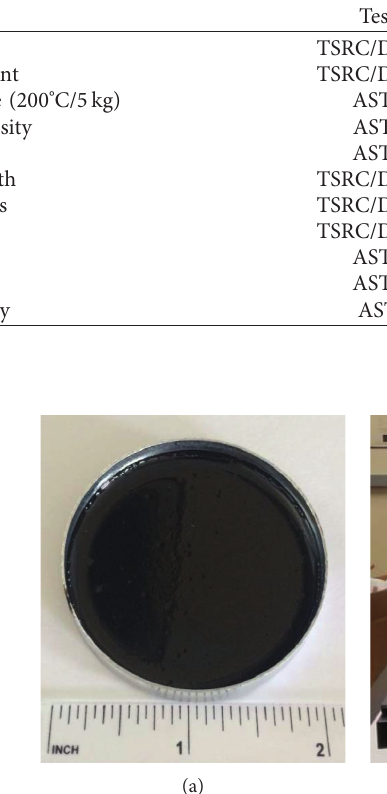
Table 1: Properties of SIS modifier.